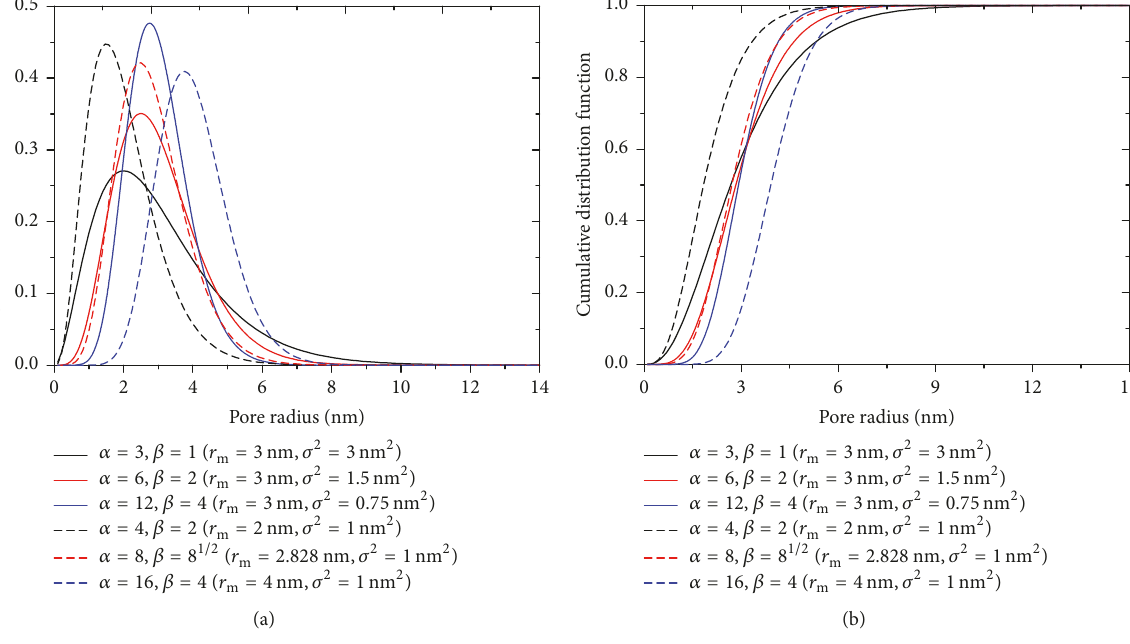
Figure 1: Representative plots of the gamma distribution: (a) probability density function, (b) cumulative distribution